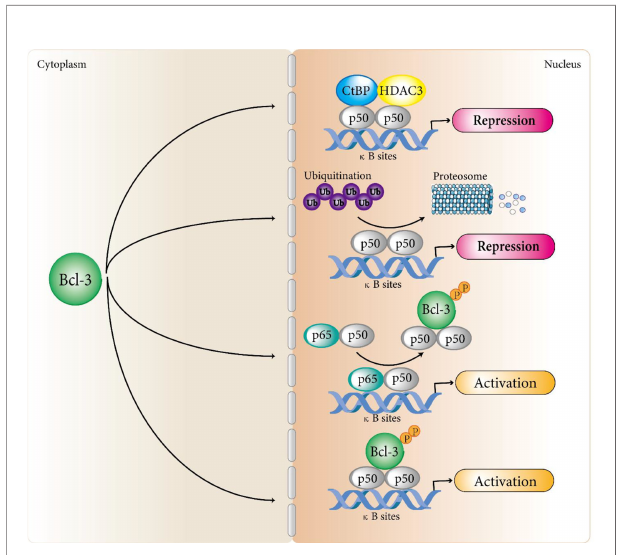
FIGURE 1 | Bcl-3 regulates atypical NF- k B signaling pathways. Bcl-3 acts as a regulator of the atypical NF- k B pathway by binding to processed p50